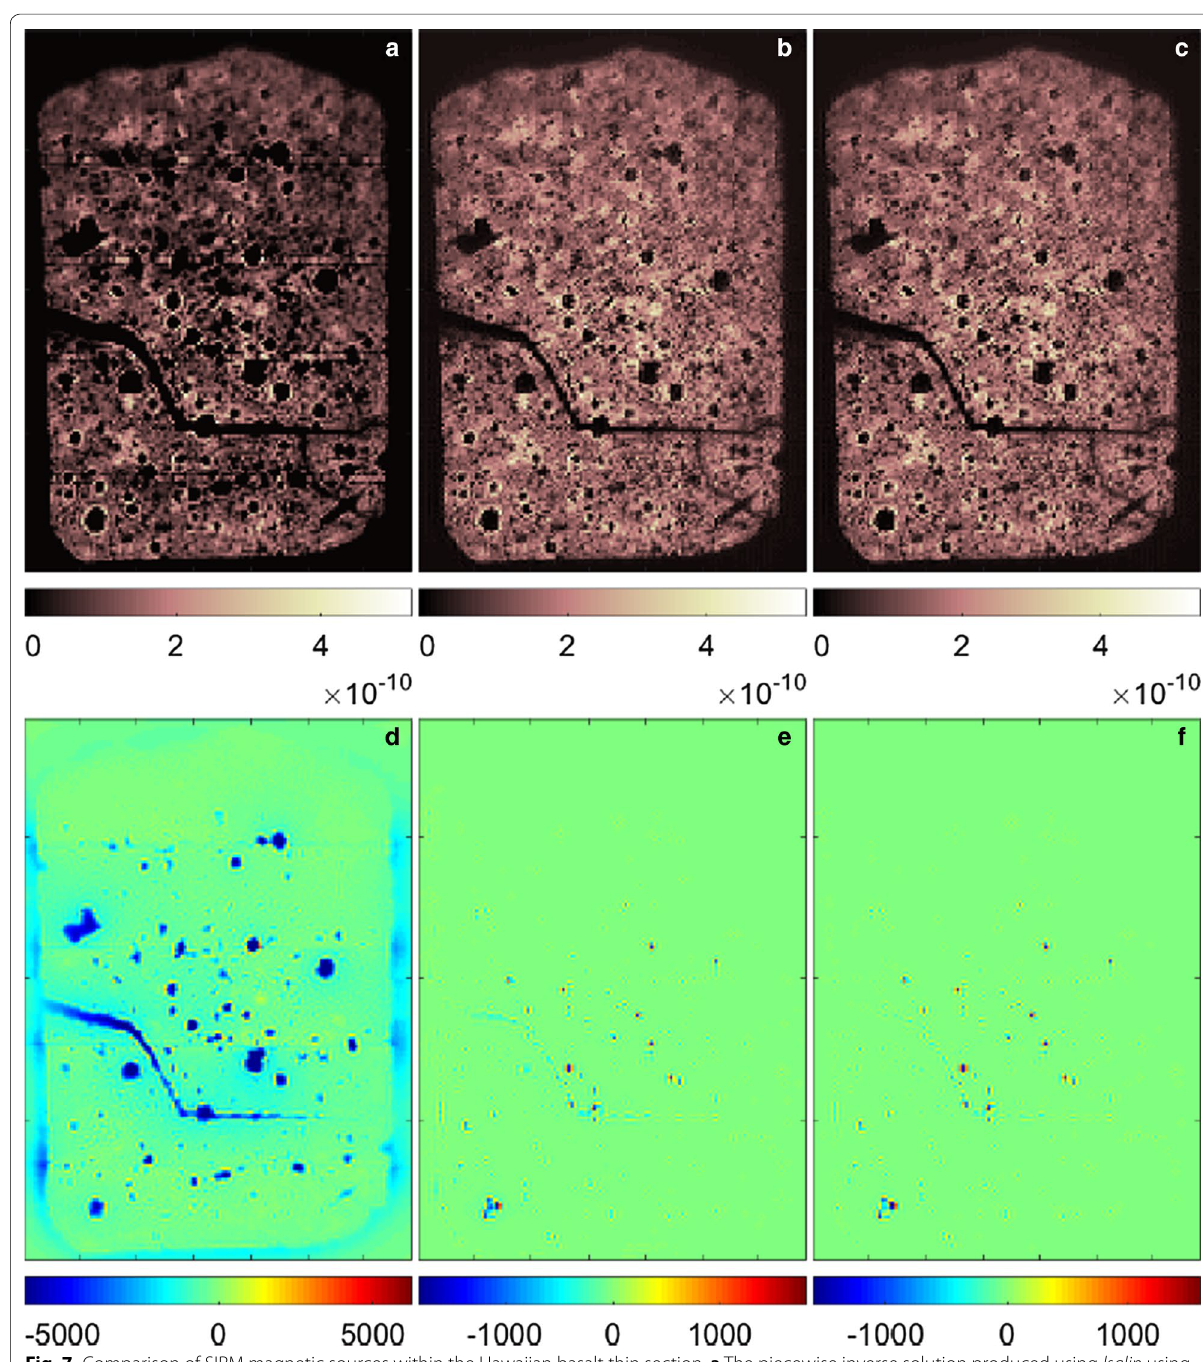
Fig. 7 Comparison of SIRM magnetic sources within the Hawaiian basalt thin section. a The piecewise inverse solution produced using lsqlin using sample subdivision (for a cropped 13.6 mm × 19.1 mm region of the original scan). b The inverse solution produced using TNT-NN for a cropped 13.6 mm × 19.1 mm region of the original scan. The lsqlin solution for the same scenario is visually identical. c The inverse solution produced using TNT-NN for the full 19.0 mm × 25.0 mm scan region cropped to a 19.1 mm × 13.6 mm view. d Solution residuals for ( a ). High-magnitude residuals at subdivision interfaces are evident as blue fringing-fields at the sample boundaries. e Solution residuals for ( b ). The lsqlin solution residuals for the same scenario are visually identical. f Solution residuals for ( c ). The field of view of each image is 13.6 mm × 19.1 mm, dipole orientation is out of page, and units are Am 2 for a – c and nT for d –